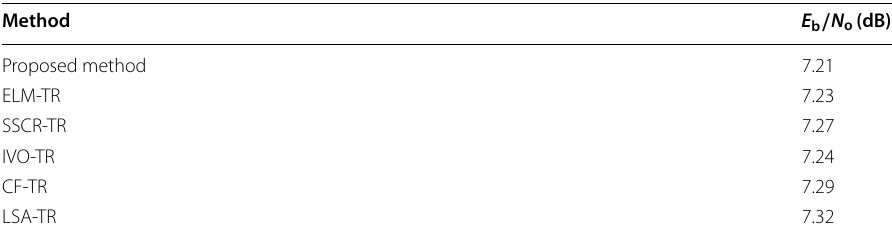
Table 5 Required E b / N o at BER